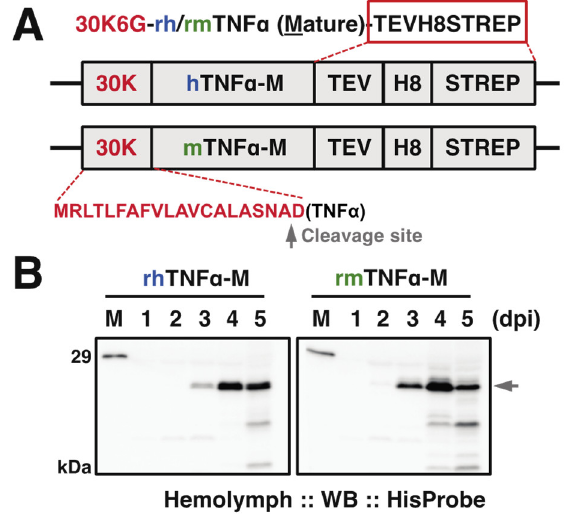
Figure 1. ( A ) Expression cassette of the recombinant baculovirus for hTNF α and mTNF α . pDEST8- hTNF α or -mTNF α was employed to generate the recombinant baculovirus (strain Q4), respectively. 30K6G (30K): a signal peptide from silkworm endogenous 30K protein 6G for the sufficient secretion of TNF α . A gray arrowhead indicated the predicted cleavage site for 30K signal peptide by SignalP 5.0 (http://www.cbs.dtu.dk/services/SignalP/(accessed on 29 May 2021)). hTNF α : mature type of human TNF α ; mature type of mTNF α : murine TNF α , TEV: tobacco etch virus protease cleavage site; H8: 8x Histidine tag; STREP: Strep-tag. C-terminal tags were marked in the red rectangle. ( B ) Time course of expressed TNF α in hemolymph from baculovirus-infected silkworm larvae at indicated day post-infection (dpi). Western blot was done using anti-HisProbe, and the arrowhead indicated the expressed TNF α in full length. M: molecular mass